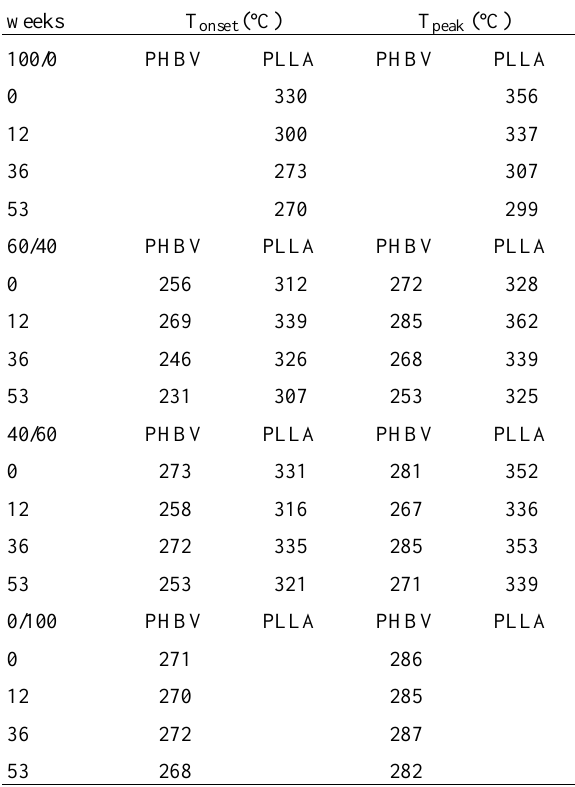
Table 1. Values ofInitialTemperatureofmassloss(T onset )and Tempera- ture of maximum mass loss (T peak ) for the PLLA/PHBV blends obtained by TGA, in different compositions of the blends in relation to degradation period